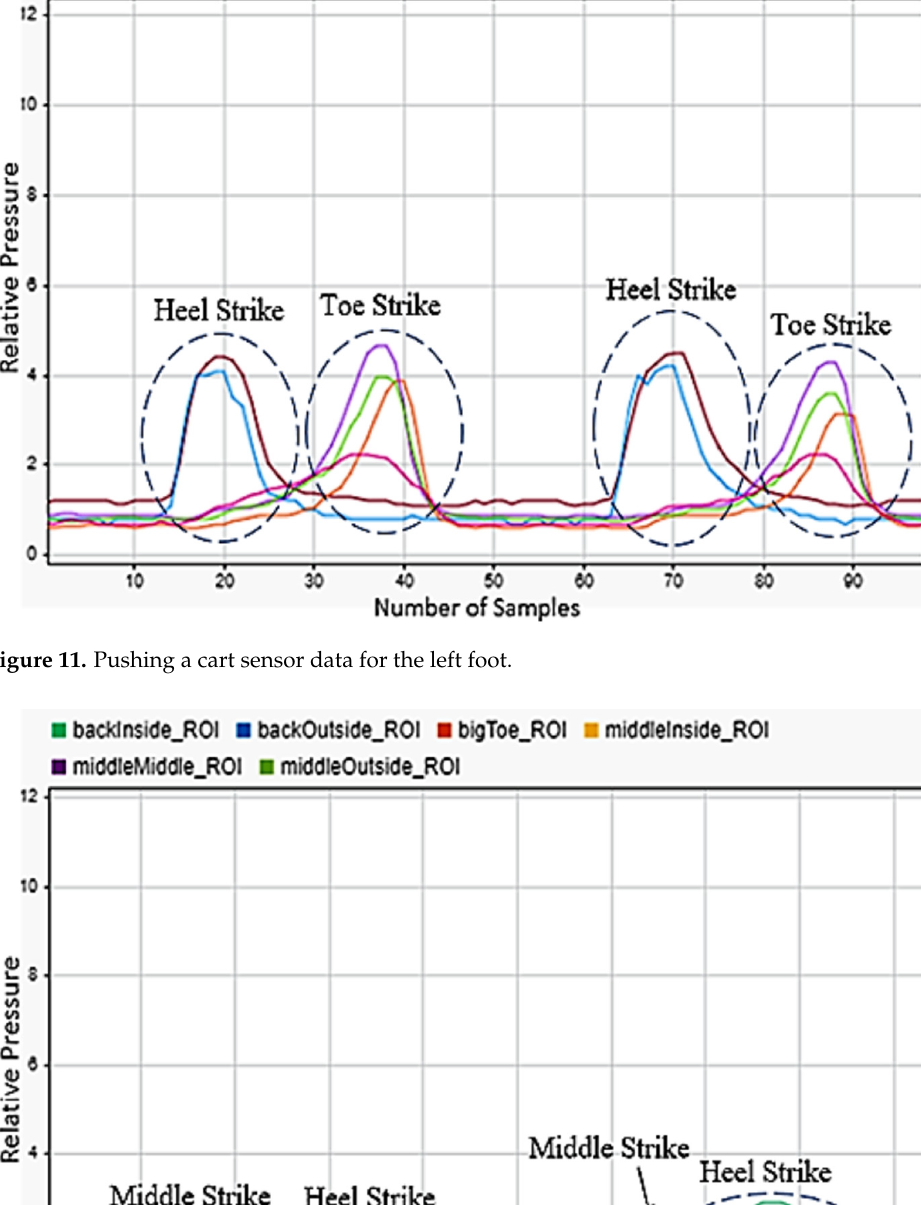
the front of the foot contacting the ground first with pressure predominantly on the very